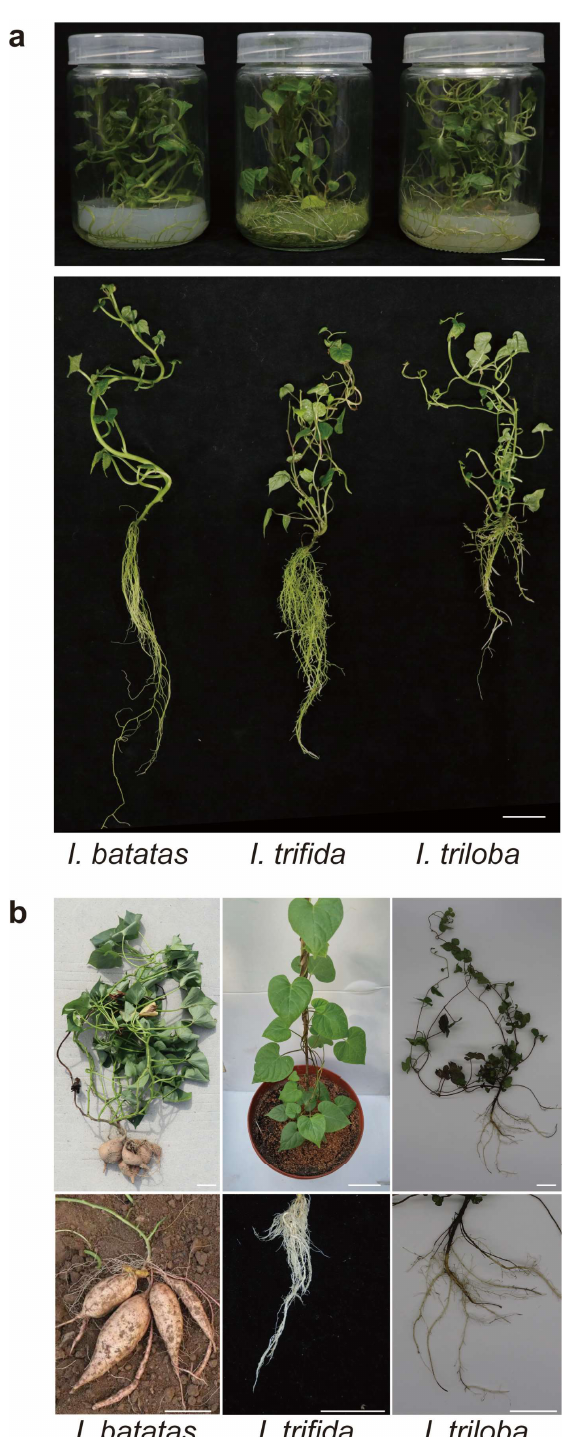
Figure 1. Plant morphology of in vitro grown ( a ) and field-grown plants. Scale bars, 2 cm. ( b ) of I. batatas , I. trifida , and I.triloba. Scale bars, 5 cm.